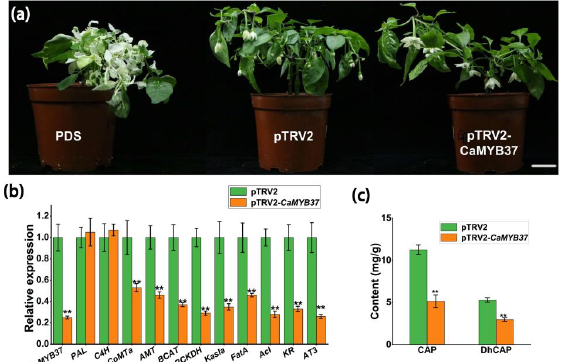
Figure 7. Expression level of CBGs/CaMYB37 and contents of CaP/DhCaP in the control (empty vec- tor) and CaMYB37 -silenced fruit placenta. ( a ) Phenotypes of control, pTRV2- PDS , and pTRV2- CaMYB37 plants. Scale bars, 10 cm. ( b ) Relative expression of CaMYB37 and CBGs in the placenta at developmental stage 16 DPA in the CaMYB37 -silenced fruit compared to levels in the control. The relative expression levels of the CBGs and CaMYB37 in the control were set to 1, and those in the CaMYB37 -silenced fruit placenta were measured relative to the control. ( c ) Contents of CaP and DhCaP in the control and CaMYB37 -silenced fruit placenta. Error bars indicate means ± SEs ( n = 3). ** means extremely significant difference ( p < 0.01).